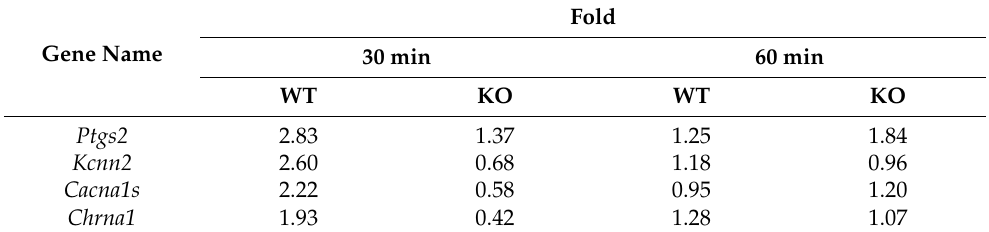
Table 1. Genes involved in sweat secretion that changed upon PACAP addition. The gene expression data are publicly available under the GEO series accession number GSE223124